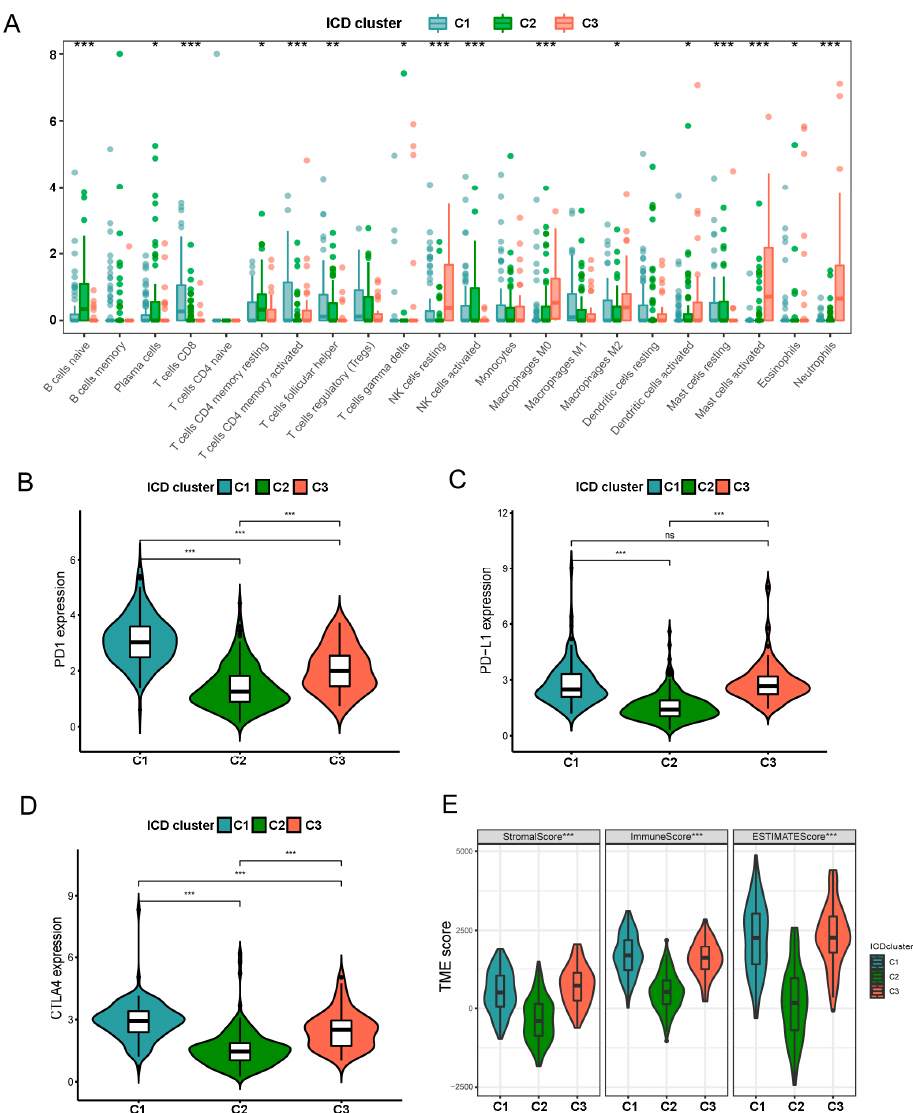
Figure 3. ( A ) The abundance of 22 infiltrating immune cell types between the three ICD-related clusters were analyzed by CIBERSORT in TCGA cohort. ( B – D ) Differential expression of PD-1, PD-L1, and CTLA4 in the three ICD-associated subtypes. ( E ) Correlations between the three ICD clusters and TME score. p values were shown as: * p < 0.05; ** p < 0.01; *** p < 0.001. TIME, tumor immune microenvironment; TME, tumor microenvironment.